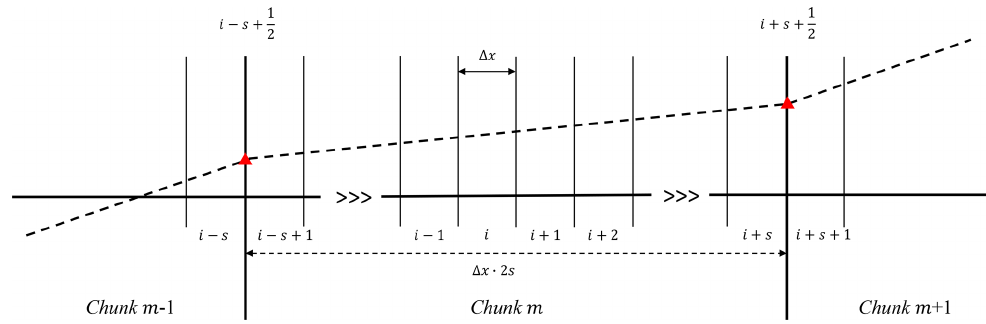
Figure 2. Schematic of grid cells within effective